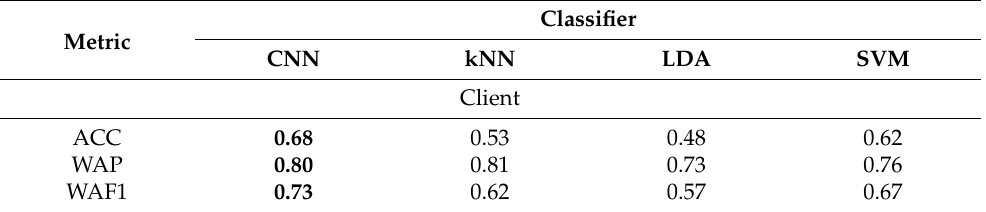
Table 13. Verification in voice channel including transcriptions and